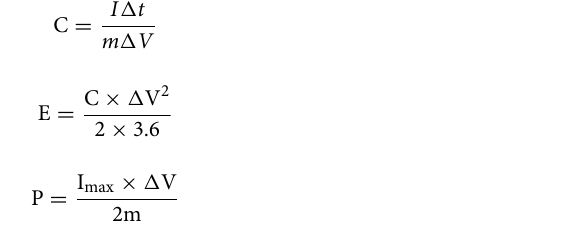
where I is the constant discharge current (A), Δt is the discharge time (sec.), ΔV is the operating potential window (V), m is the mass of the loaded active material on one electrode (g) and I max is the maximum current used for discharge. The optimized microwave time for this procedure is 60 s. Theoretically, its preferable particle size and